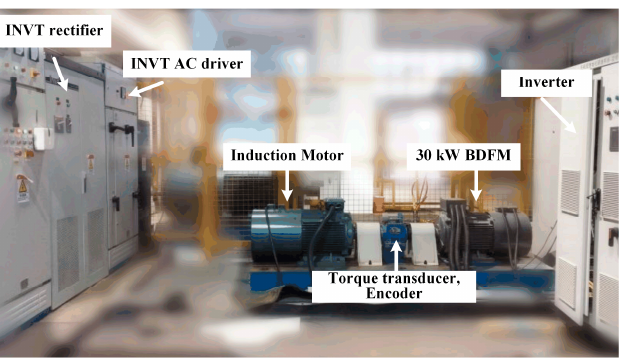
Figure 9. The brushless doubly-fed induction machine test rig.